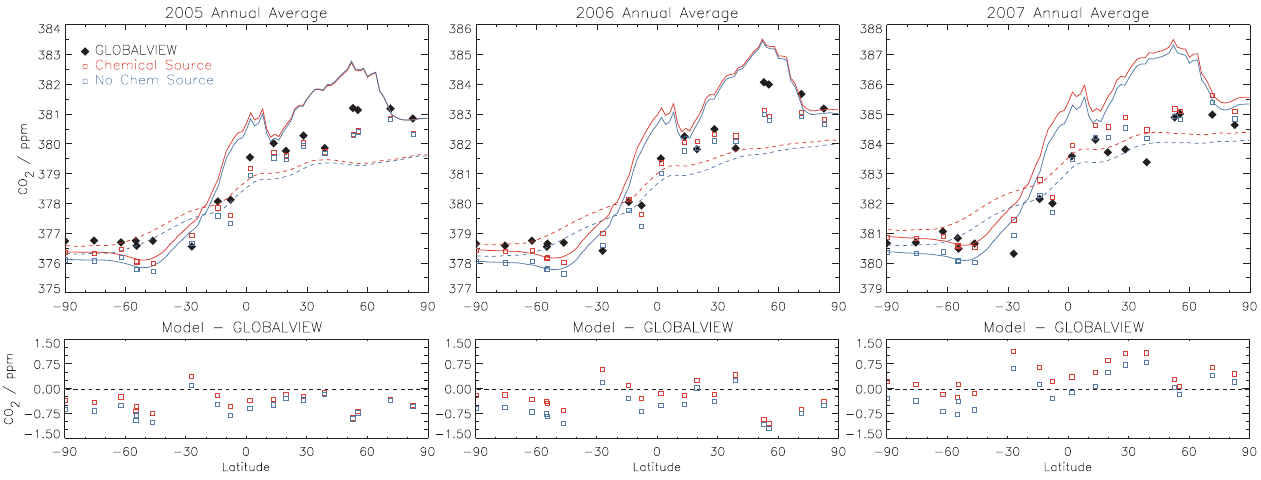
Fig. 14. The upper panels show the annual average CO 2 as a function of latitude for 2005–2007 from GEOS-Chem with the chemical source (red) and without (blue). The zonal average at the surface (solid line) and the zonal average at the model level near 5km (dotted line) are shown along with single pixels compared with 18 selected GLOBALVIEW stations (black) denoted in Table 3. The lower panels show the model GLOBALVIEW difference at the surface for the two simulations (colored as above), both of which started from a uniform 3-D global CO 2 field of 375ppm on 1 January 2004. Table 4. GLOBALVIEW-CO 2 and unconstrained model simulations (with/without chemical source) showing CO 2 (ppm) at the South Pole and the CO 2 offsets at Mauna Loa and Alert relative to the South Pole values. Year South Pole Mauna Loa